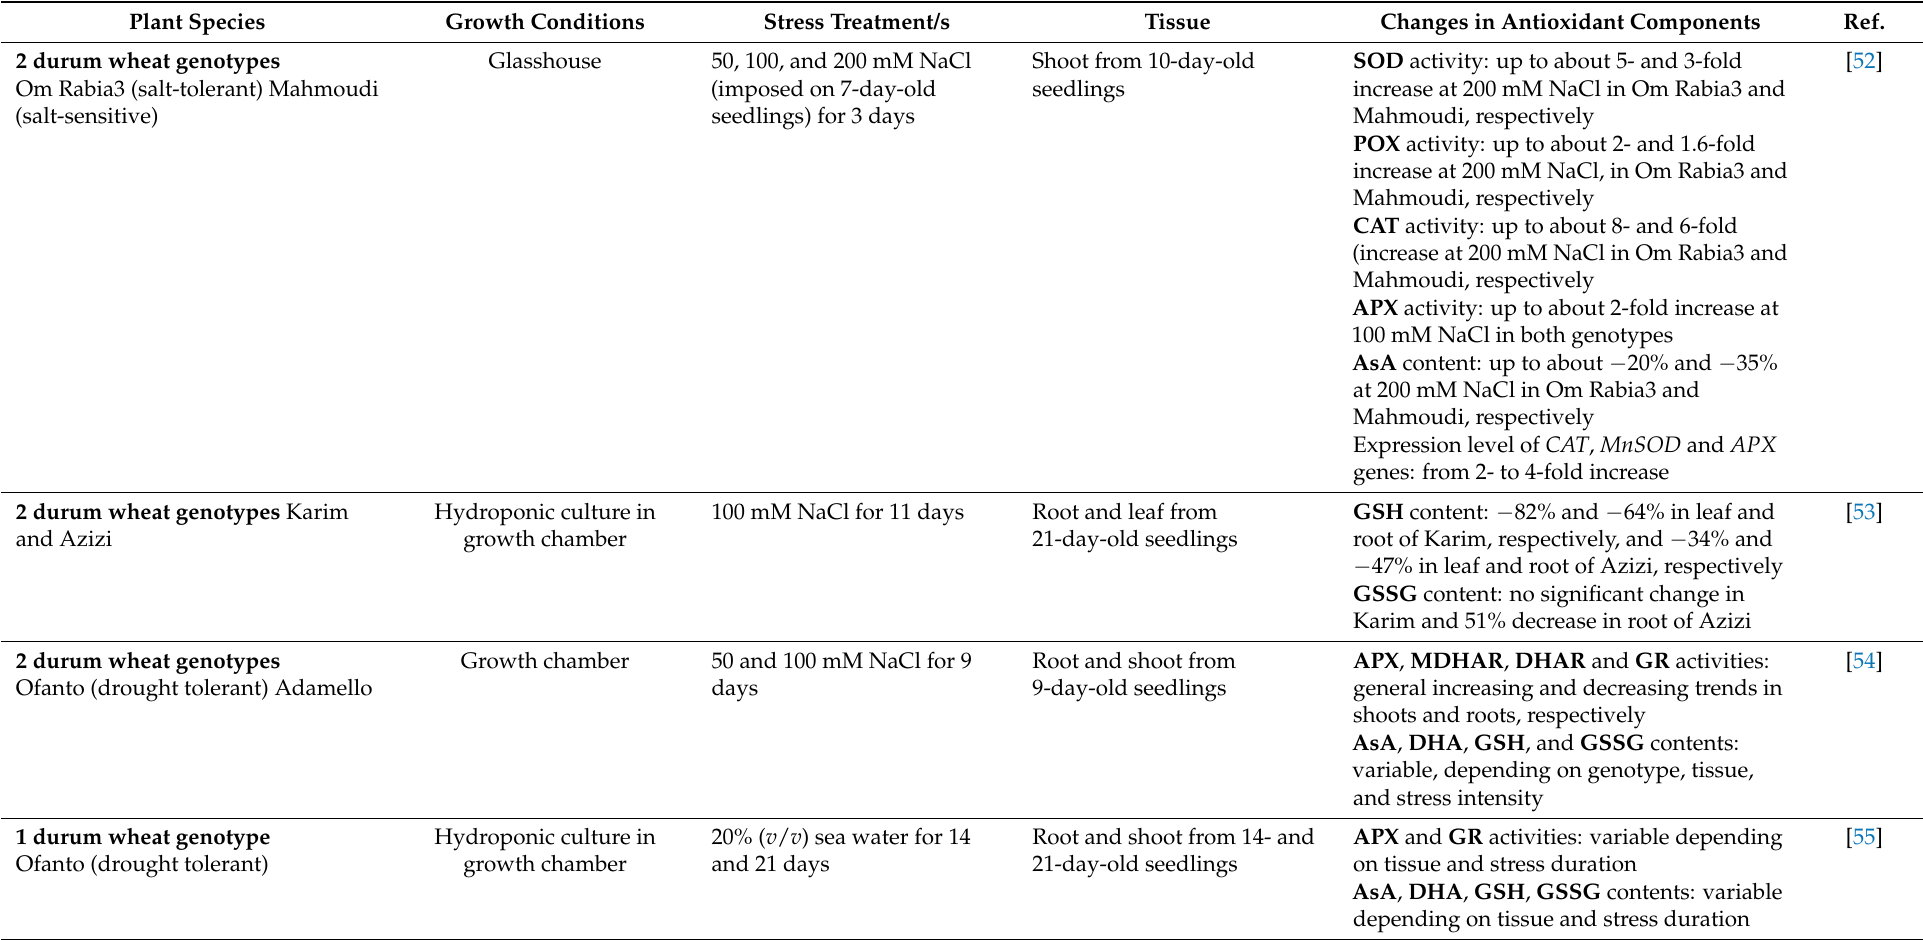
Table 2. Changes in antioxidant defence system in durum wheat under salt stress. Effects were estimated from graphs, figures and tables if not directly given in the text or